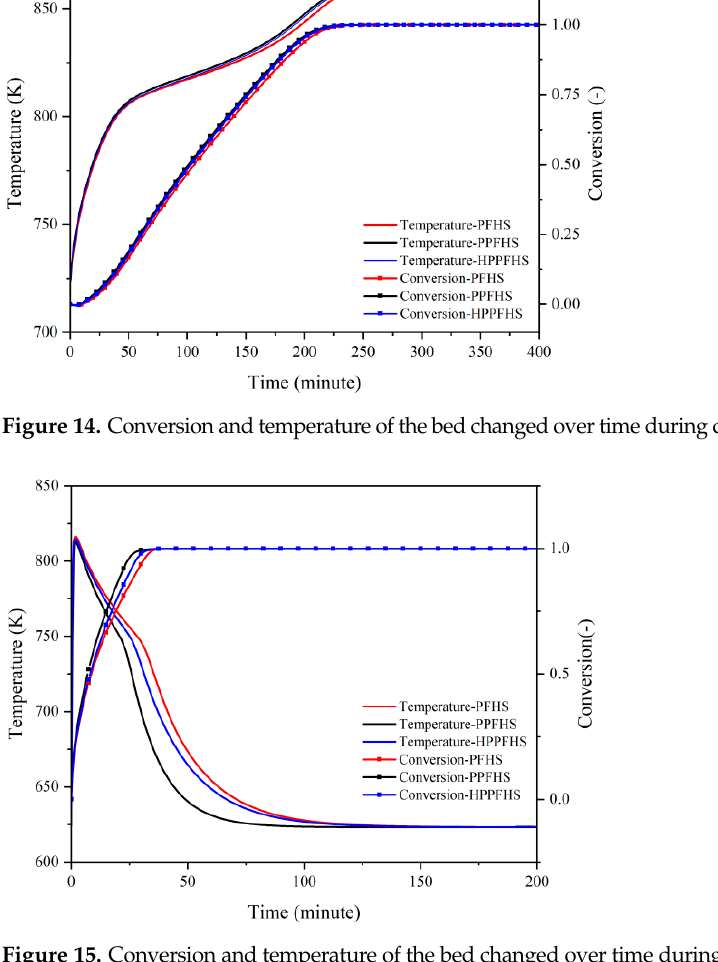
Figure 15. Conversion and temperature of the bed changed over time during hydration ( ε = 0.8, 25 m/s).